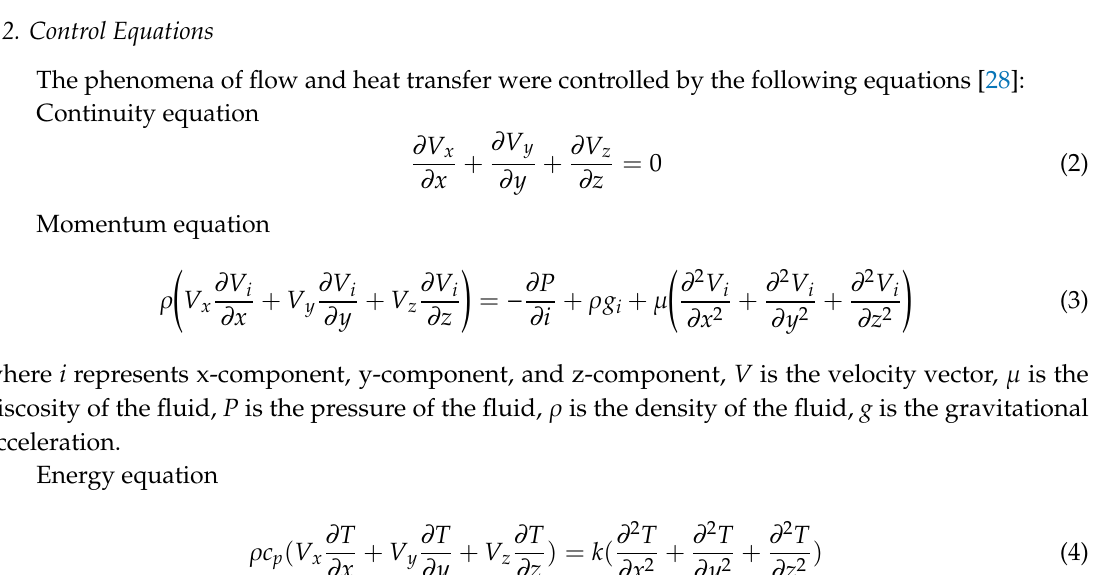
Figure 1. Computational domain and boundary conditions.